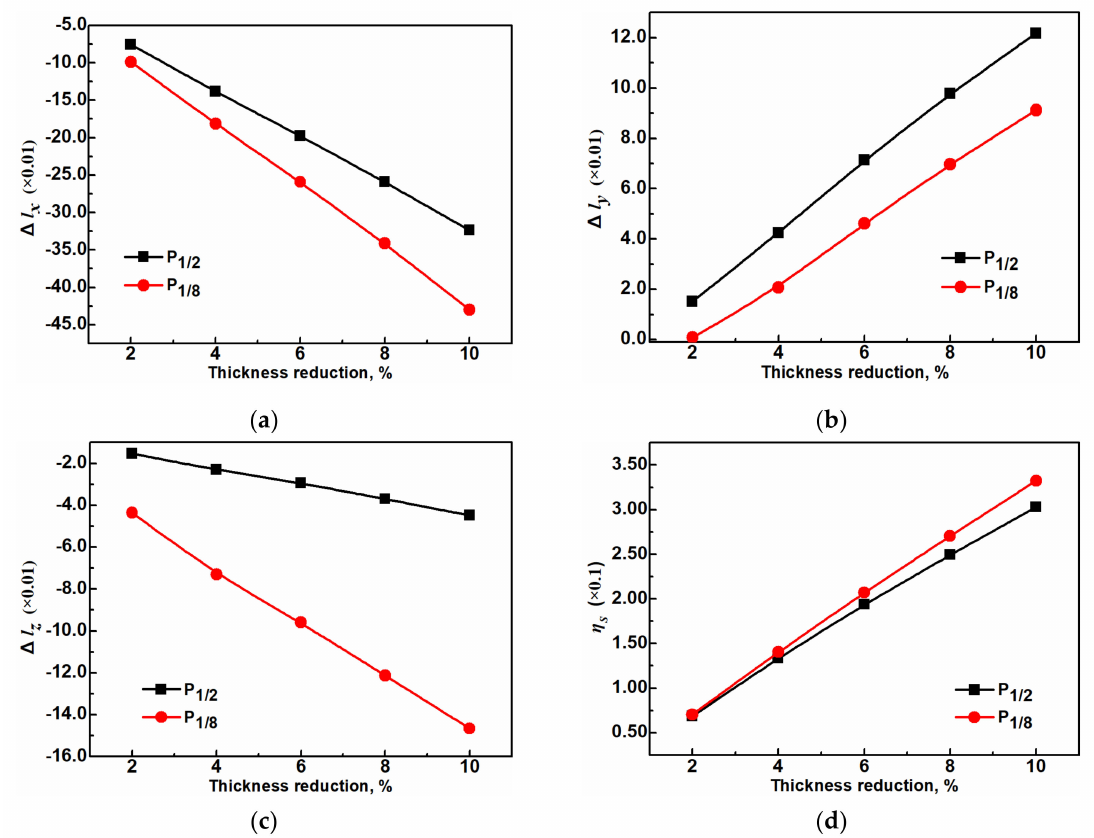
Figure 10. Porosity deformation degree along the ( a ) slab thickness direction, ( b ) casting direction, ( c ) width direction, and ( d ) the porosity closure degree after different heavy reduction (HR)